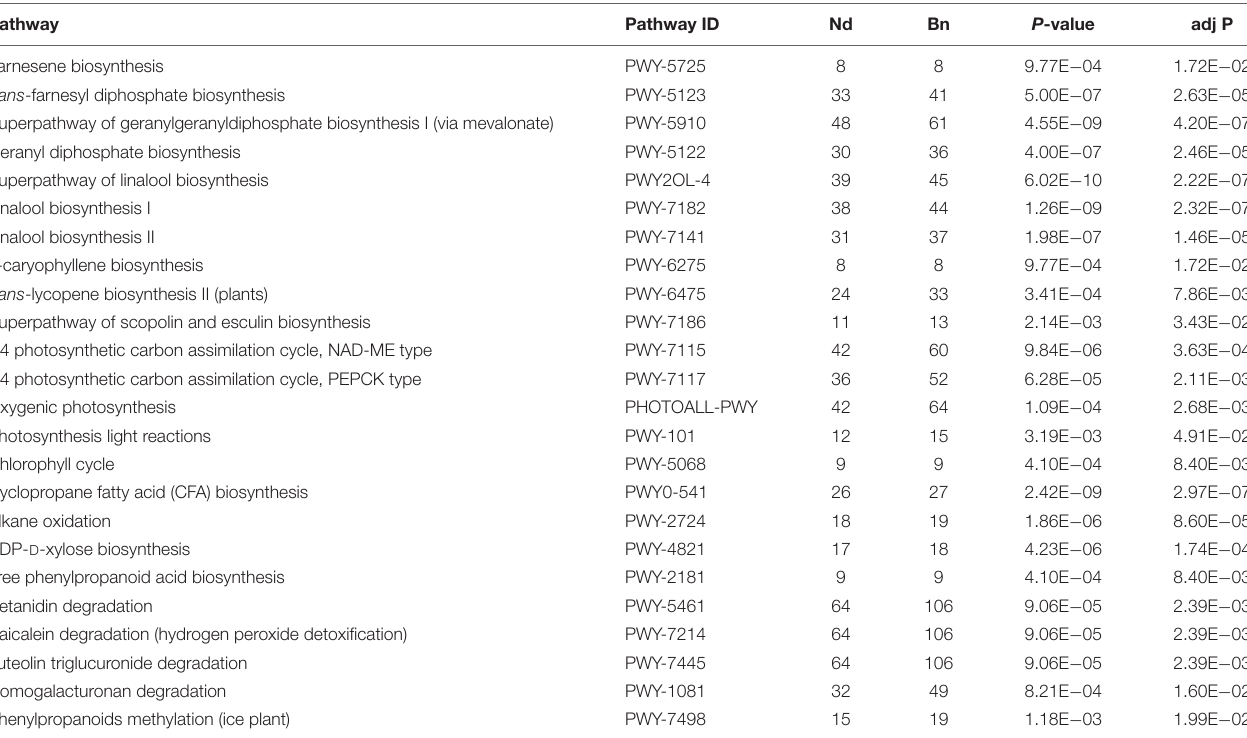
TABLE 3 | Kyoto Encyclopedia of Genes and Genomes (KEGG) functional classification for leaves and roots transcriptome of A. bidentata .